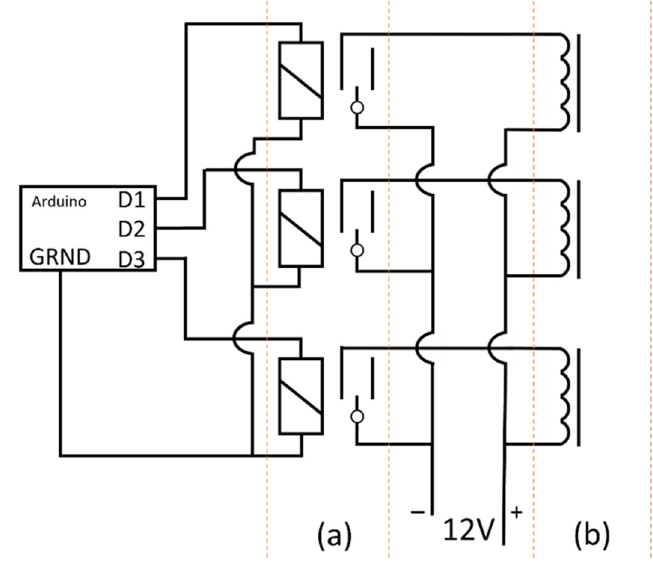
Figure A7. Circuit diagram of the described setup consisting of an Arduino, three relays (a) and three electromagnets (b) .